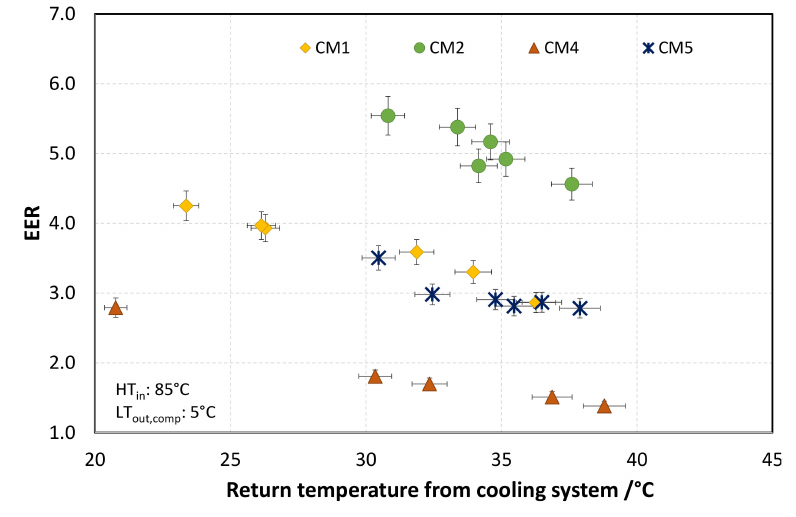
Figure 14. EER for different cooling modes.